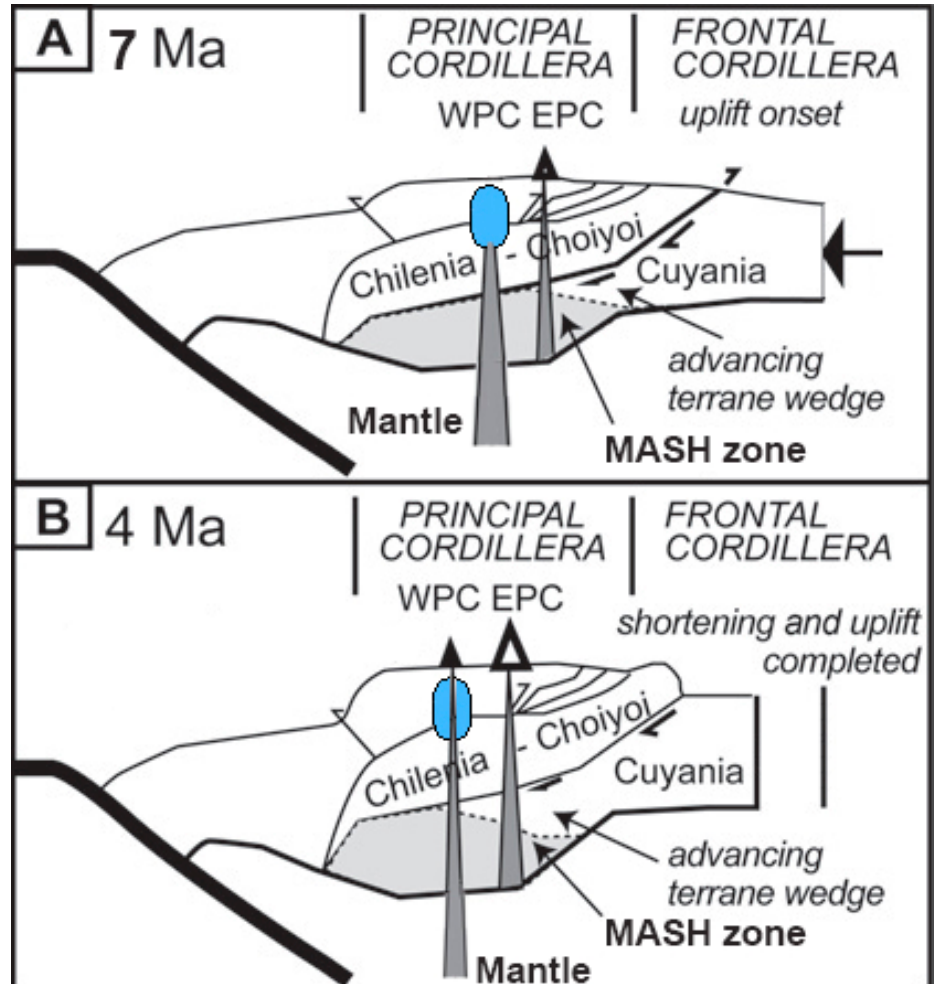
Figure 8. Schematic profiles [18–20,24] of crustal evolution of the Andes of central Chile and Argentina at 7 Ma ( A ) and 4 Ma ( B ). Evolution is characterized by increased shortening rates along the eastern flank of the orogenic belt after 7 Ma, where the Chilenia-Choiyoi block overrides the Cuyania terrane, producing uplift of the Frontal Cordillera. This also produced increasing crustal thickness, which led to uplift of the entire belt. Deformation amounts suggest that the Cuyania block descended immediately below the eastern part of the magmatic arc, changing composition of the base of the crust and thus changing the crustal magmatic source (MASH zone) below the Eastern Principle Cordillera (EPC). However, below the Western Principle Cordillera (WPC), mafic magmas continued to rise from the mantle without intra-crustal assimilation in a MASH zone. Between 7 and4 Ma, these mantle-derived mafic magmas did not reach the surface, but were mixed, stored and homogenized in a large magma chamber (blue) below El Teniente. Within this chamber, the felsic plutons of the deposit developed without crustal assimilation and above it the mineralized breccias in the deposit were emplaced (see Figure 10). As subduction angle flattened and magma supply from the mantle decreased this chamber solidified. After 4 Ma, high-MgO olivine lamprophyres and olivine-bearing basaltic andesites, derived from a mantle hydrated and isotopically modified by increased proportions of subducted crust and sediment (Figure 7), rose through the now crystallized magma chamber, without any intra-crustal assimilation, to form dikes and lavas. (Reprinted from Geology, volume 41, Muñoz, M. et al., Isotopic shifts in the Cenozoic Andean arc of central Chile: records of an evolving basement throughout cordilleran arc mountain building, page 933, Copyright 2013, with fair use permission from the Geologic Society of America.).